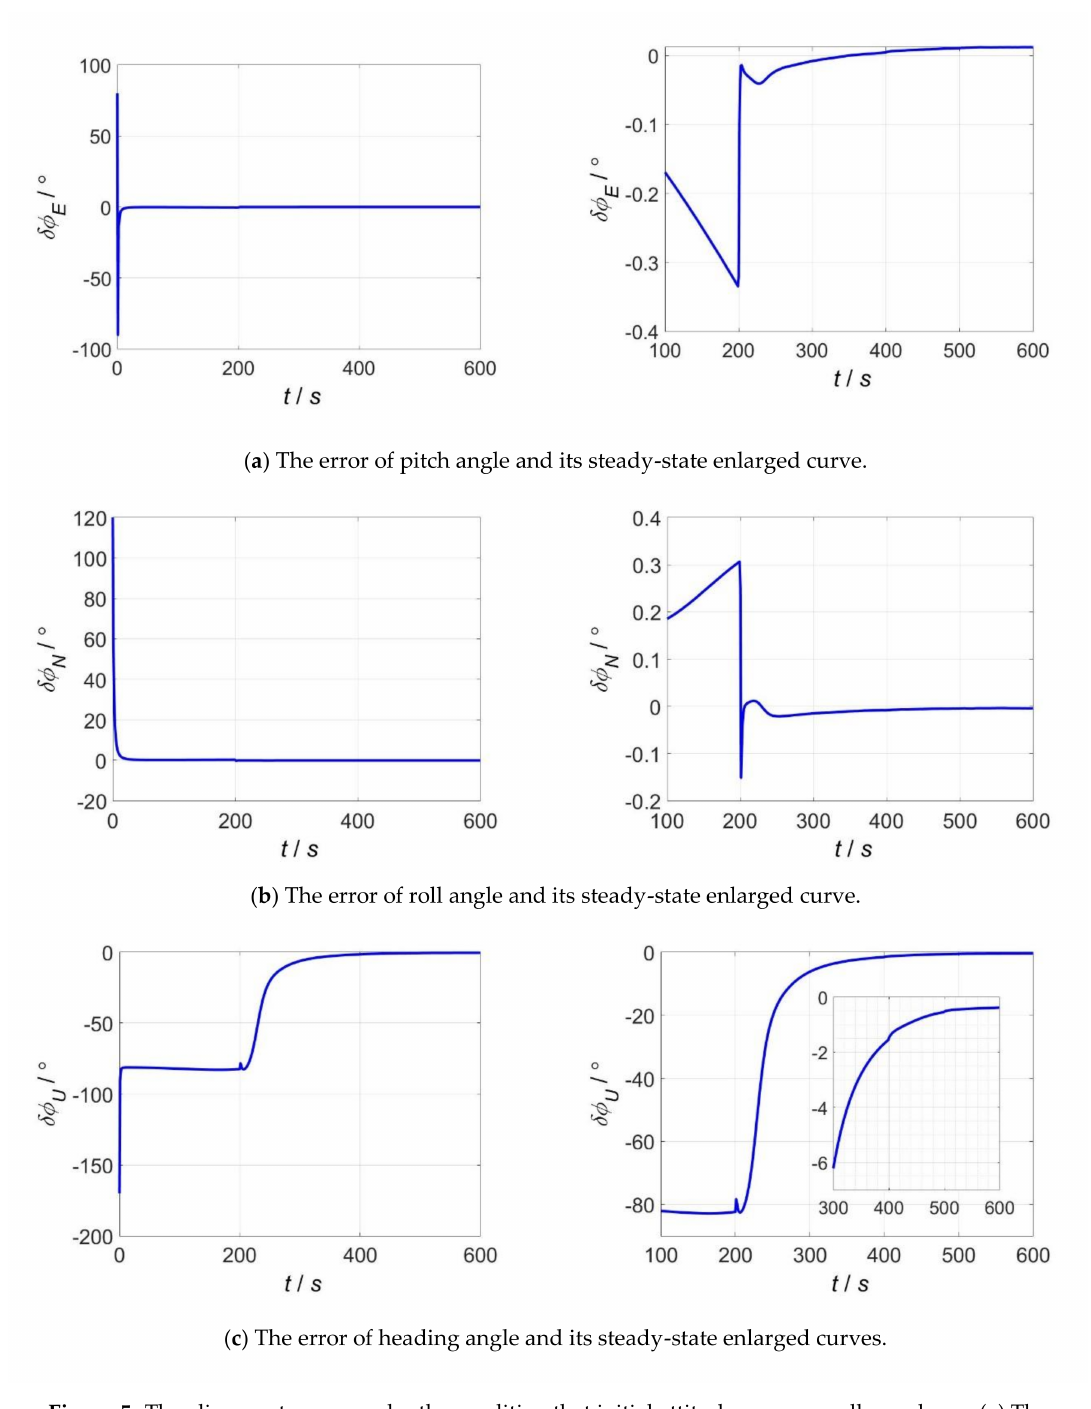
Figure 5. The alignment errors under the condition that initial attitude errors are all very large. ( a ) The error of pitch angle; ( b ) the error of roll angle; ( c ) the error of heading